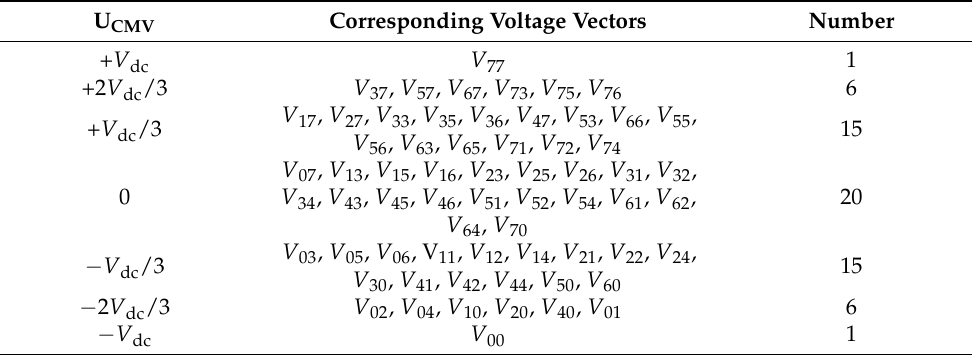
Table 3. Common-mode voltages with different voltage vectors. U CMV Corresponding Voltage